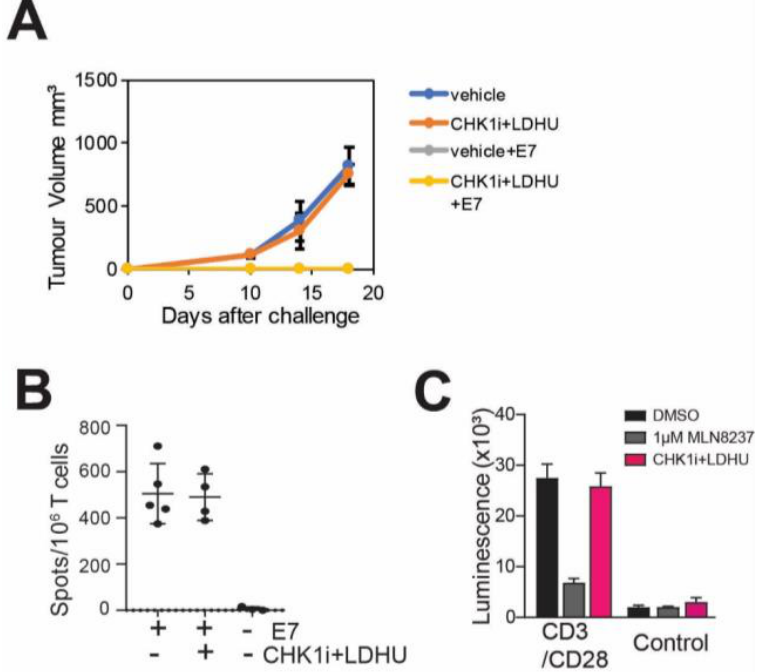
Figure 3. CHK1i+LDHU does not adversely affect a T cell-mediated immune response. ( A ).